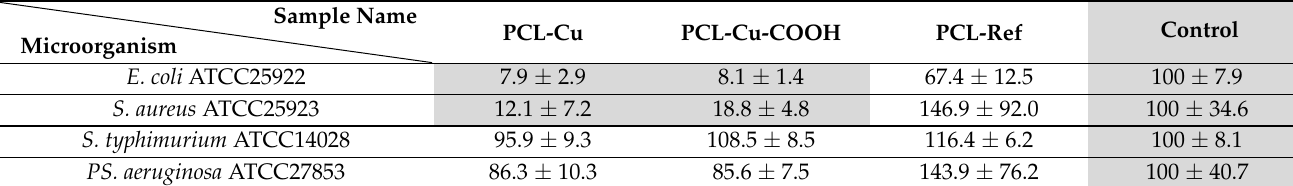
Table 3. Antibacterial activity. The percentage is of CFU relative to the CFU of the control. The reliability of the differences was calculated according to the Student’s criterion with the degree of freedom number 4 (3 + 3-2), ( p < 0.01). Positive control was performed using PCL-COOH with covalent bonded of Penicillin-Streptomycin-Neomycin (PSN) Antibiotic Mixture under the same conditions.